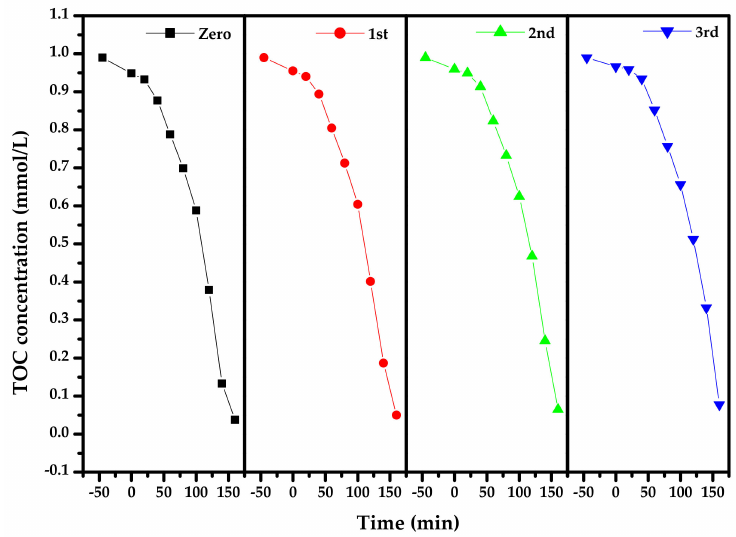
Figure 15. Concentration changing curved line of TOC during PD of DO in dye wastewater with Bi 2 SmSbO 7 /ZnBiYO 4 heterojunction as photocatalyst under VLI for 3 cyclical degradation experiments. Figure 16 exhibits the second-order kinetic curves for the PD of DO with BZH, Bi 2 SmSbO 7 , ZnBiYO 4 or N-dT as catalysts under VLI. According to Figure 16, the dy- namic constant k, which was obtained from the kinetic plot toward DO concentration and VLI time with BZH, Bi 2 SmSbO 7 , ZnBiYO 4 or N-dT as catalyst, reached 2.167 or 0.495 or 0.395 or 0.089 min − 1 , respectively. The dynamic constant k, which derived from the kinetic plot toward TOC concentration, was 0.047 or 0.010 or 0.009 or 0.002 min − 1 with BZH, Bi 2 SmSbO 7 , ZnBiYO 4 or N-dT as photocatalysts. The fact that the merical number of K TOC for removing DO was lower than the merical number of K C for removing DO, even though they were using the same catalyst, indicated that the photodegradation interme- diate products probably appeared during the PD of DO under VLI. At the same time, the degradation of DO by BZHP showed higher mineralization efficiency compared with the other three photocatalysts.